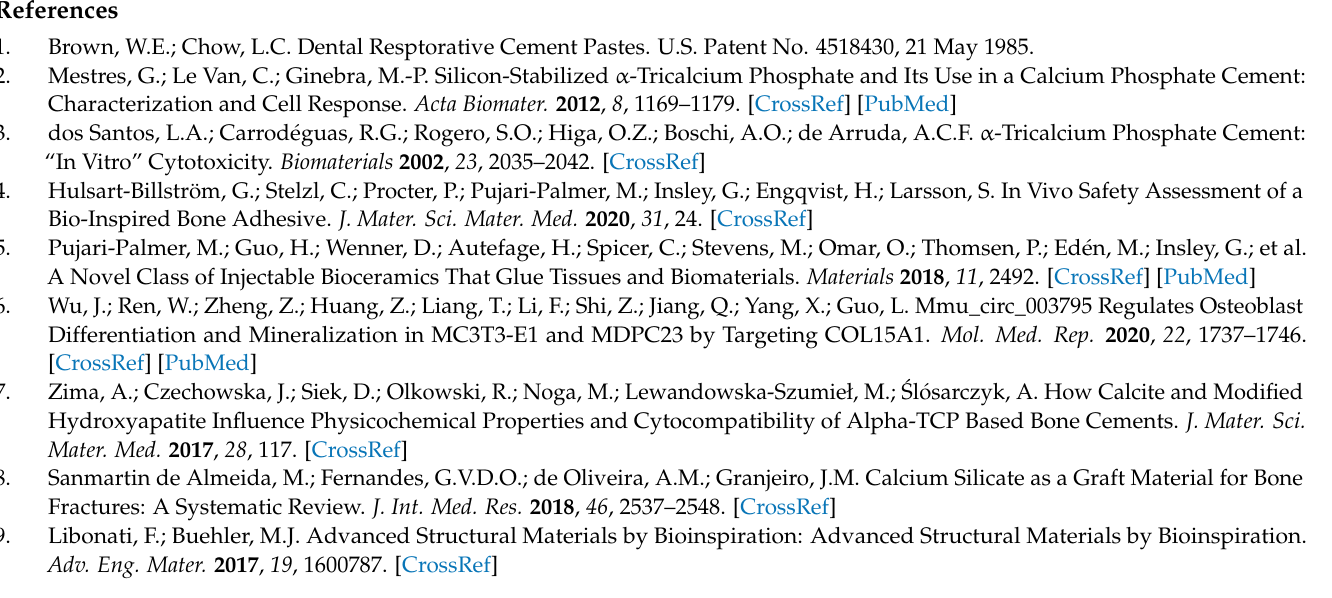
profiles. Figure S3: Effect of media replenishment on ion release profiles, for a broad formulation range. Table S1: Table of all disc formulations, including pH and setting